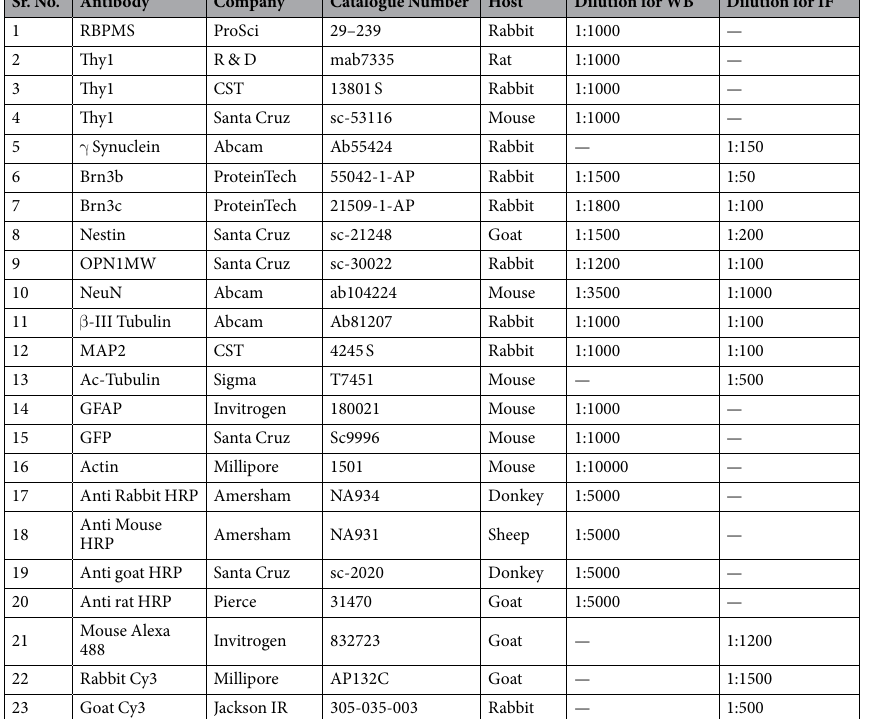
Table 1. Antibodies and their dilutions used in Western Blotting (WB) and Immunofluorescence